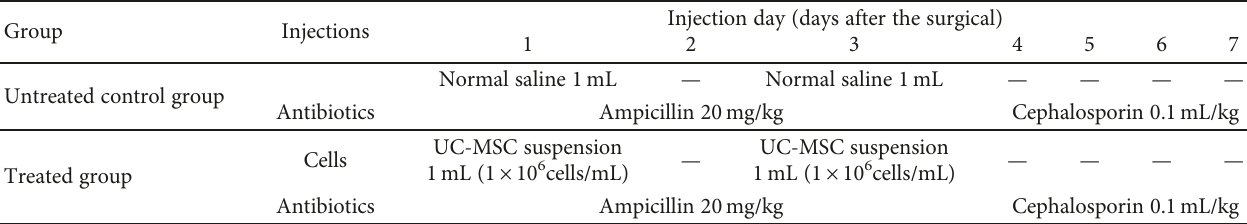
Table 1: Injection